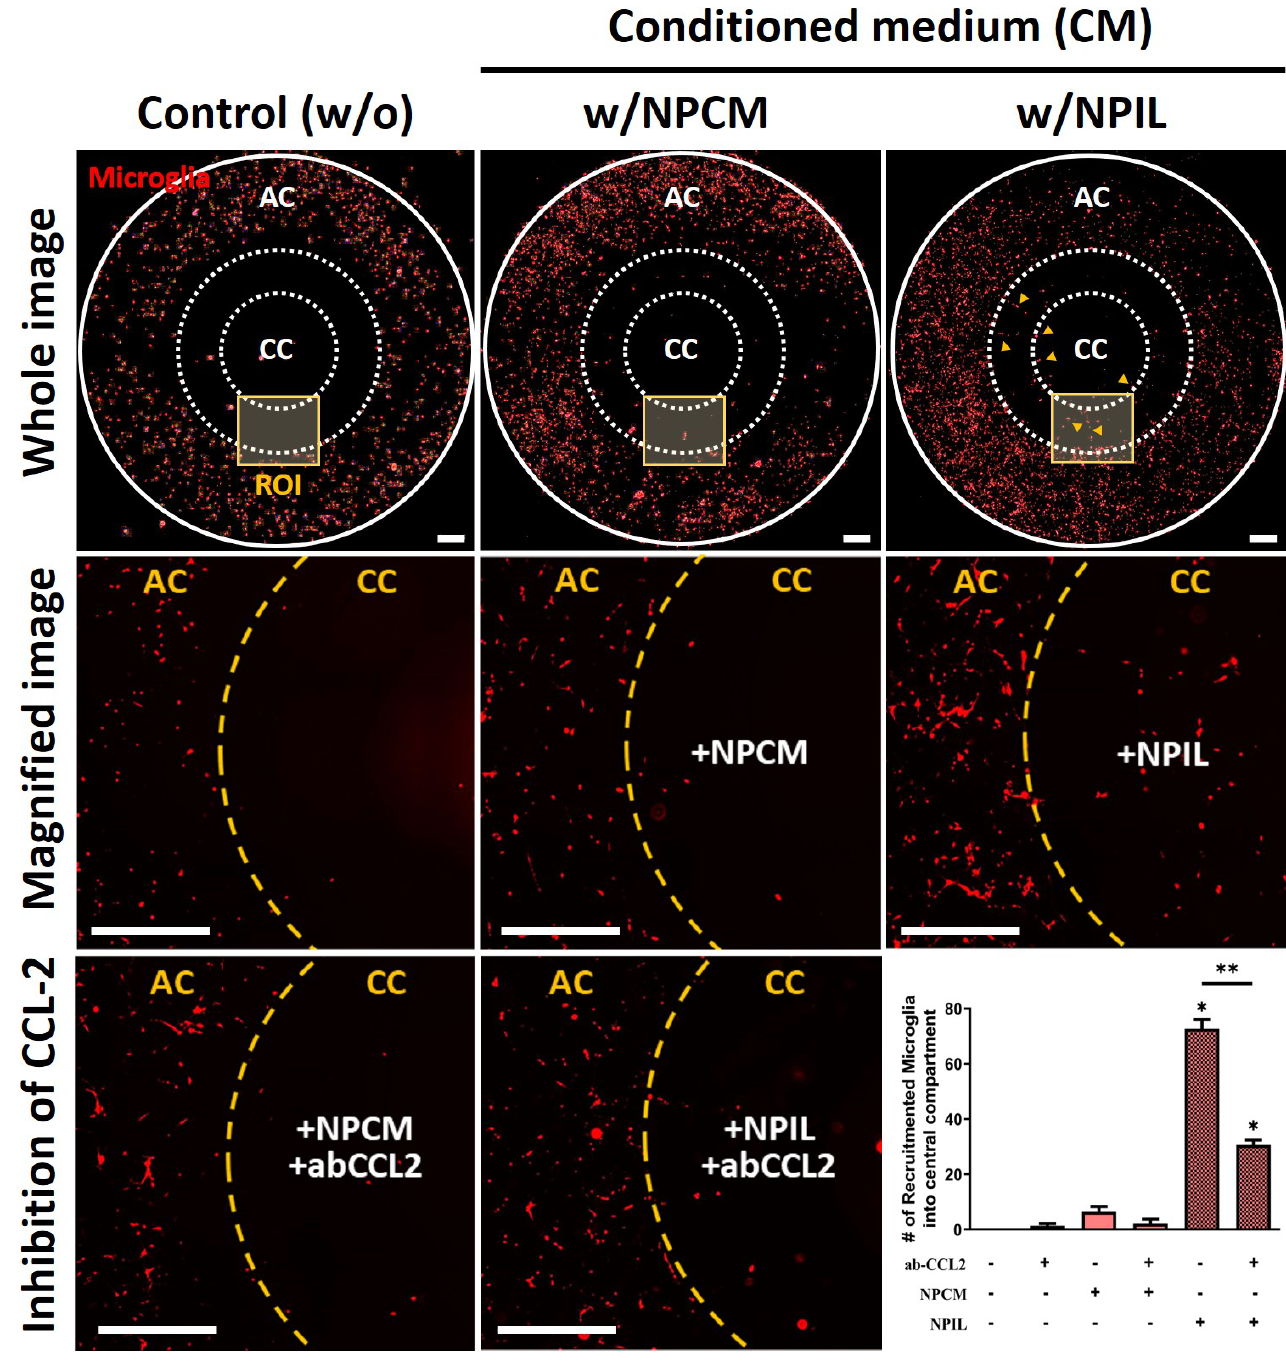
Figure 4. Recruitment of microglia using conditioned medium derived from IL − 1 β − stimulated human NP cells. Significant recruitment of microglia is observed in the central compartment (CC) containing NPIL (conditioned medium of IL − 1 β − stimulated NP cells) from the annular compartment (AC). Additionally, results show that neutralizing CCL − 2 reduced the chemotaxis effects on microglia. Scale bars, 500 μm. * p < 0.05, ** p < 0.01 as compared with naïve microglia cells. The line indicates the comparison with each group.